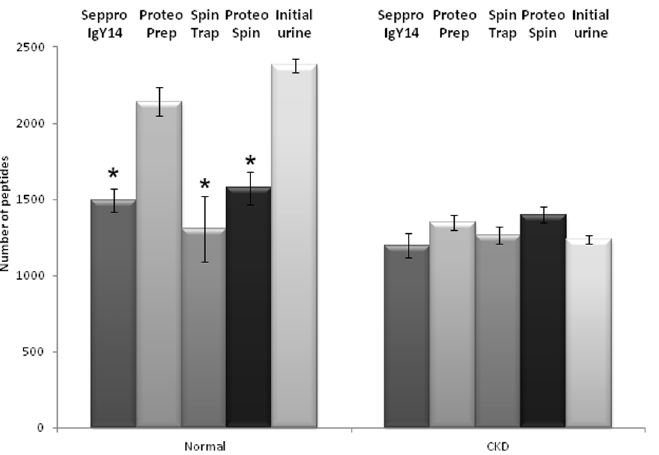
Fig 3. Average number of peptides identified per